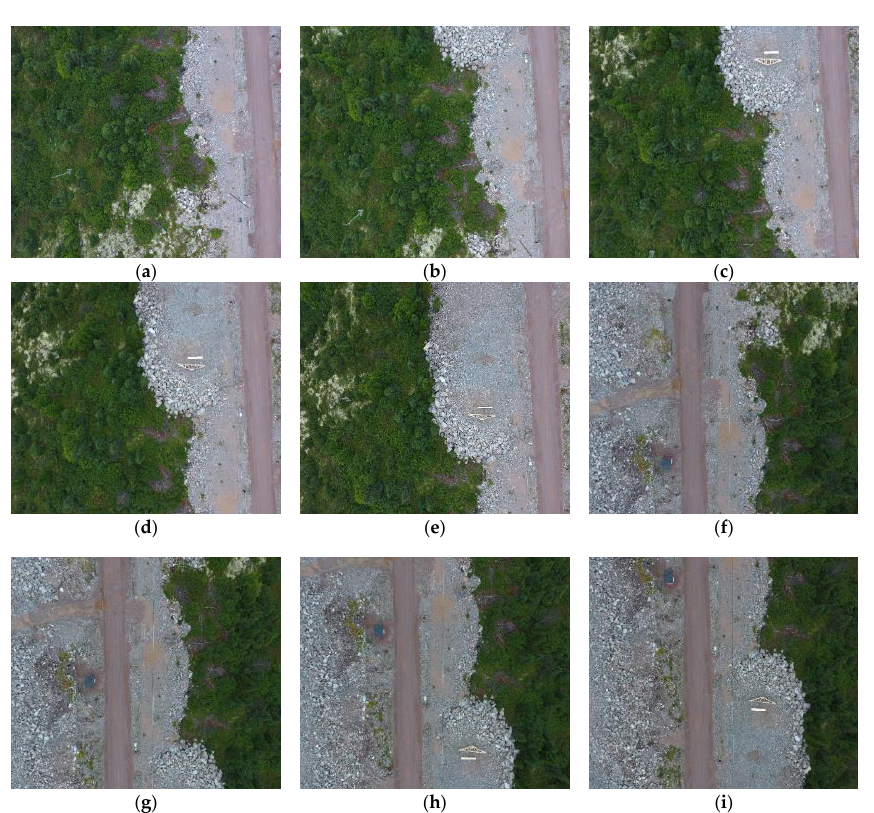
Table 3. The number of match points of UAV image pairs.